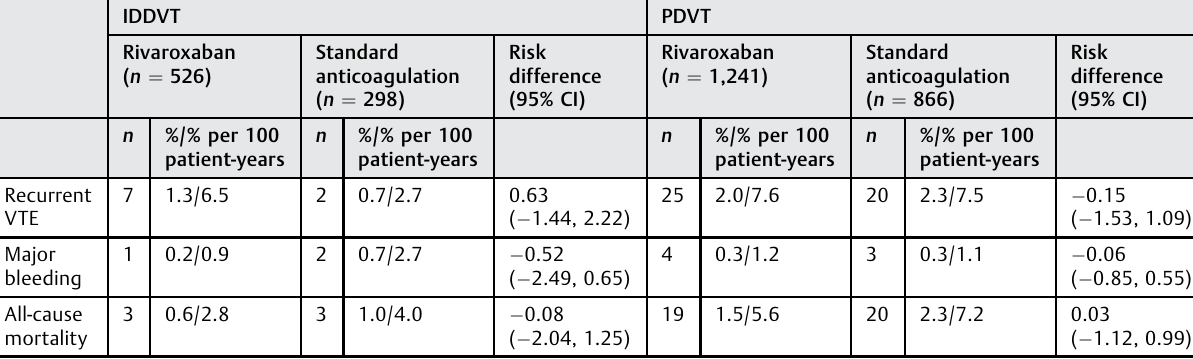
Table 6 Primary outcomes after treatment cessation in patients with IDDVT or PDVT in patients treated with standard anticoagulation or rivaroxaban who were followed up after treatment